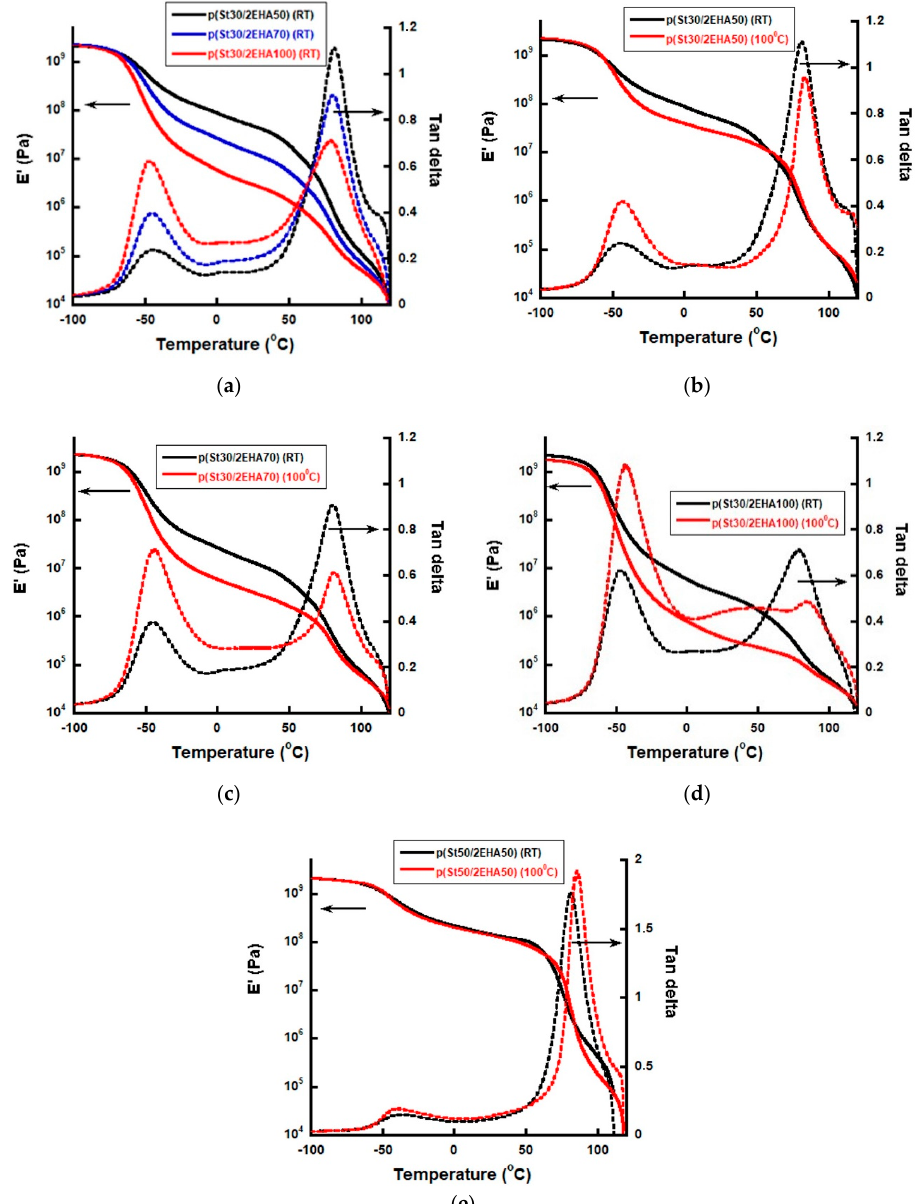
Figure 10. Viscoelastic properties of the block copolymers: a ) p(St30/2EHA50), p(St30/2EHA70) and p(St30/2EHA100) dried at RT; b ) p(St30/2EHA50) dried at RT and 100 °C; c ) p(St30/2EHA70) dried at RT and 100 °C; d ) p(St30/2EHA100) dried at RT and 100 °C; e ) p(St50/2EHA50) dried at RT and 100 °C. Solid lines = dependence of elastic modulus on temperature; dashed lines = dependence of tan δ on temperature.